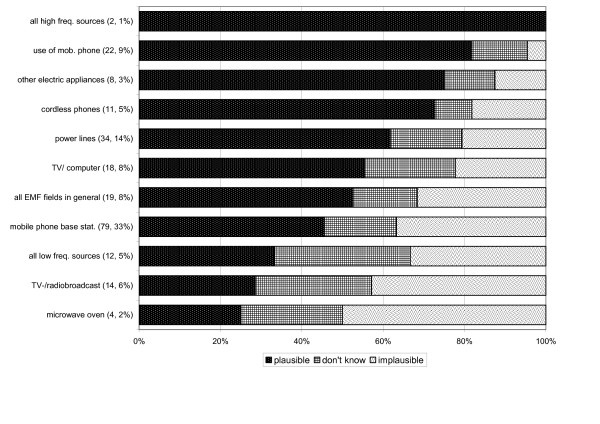
Plausibility rating of association between suspected source and symptoms, by source (absolute number as well as percentage of cases who suspected this EMF source in brackets).